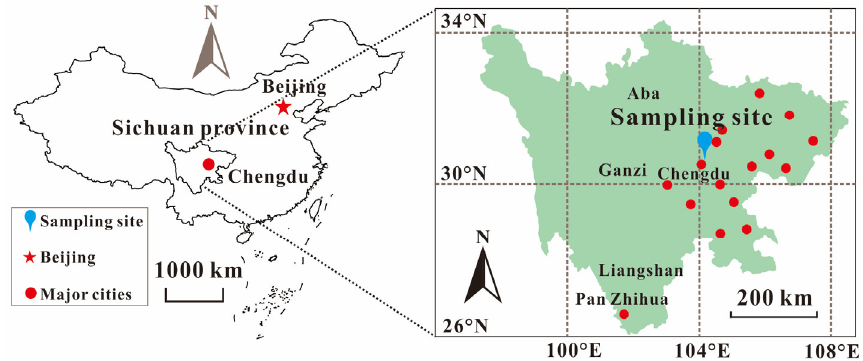
Figure 1. Sichuan region of China and sampling site in Chengdu.